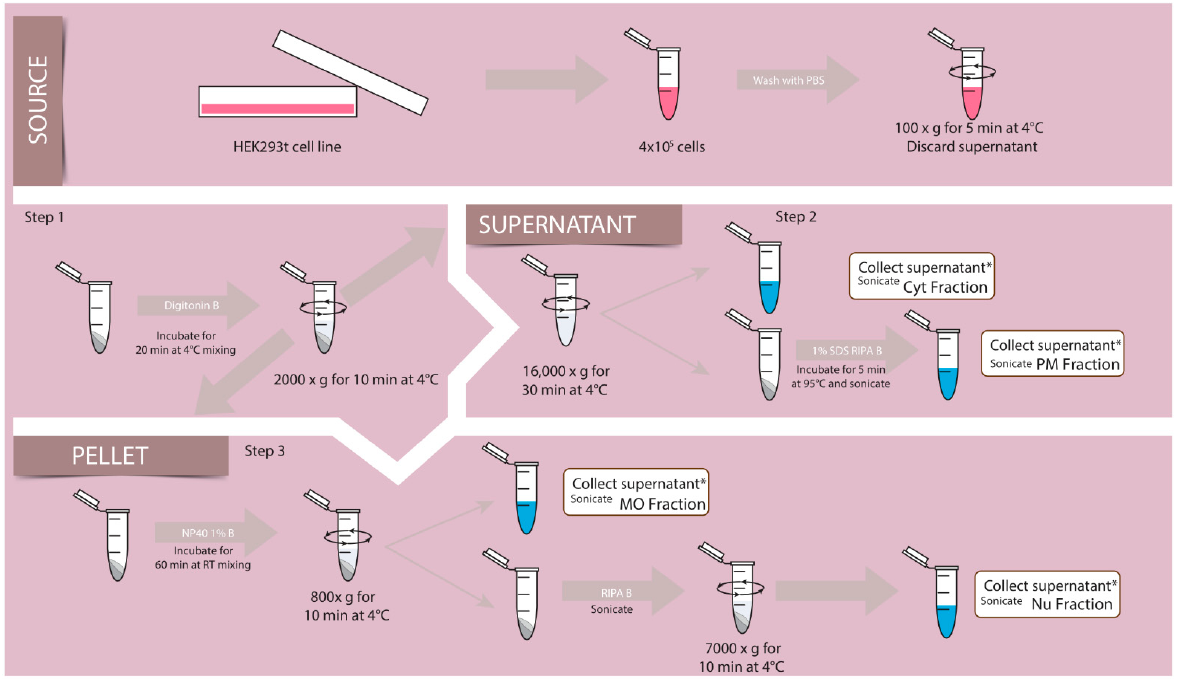
Figure 1. Schematic representation of the fractionation method. HEK293 cells (source) grown on plates were subjected to different steps to obtain the proper cell density to expose them to buffers (B) containing different detergents (arrows) and centrifugation (circle arrow) to obtain different supernatant and pellets enriched in Cyt, PM, MO, Nu fractions. Details in scheme and Material and Methods section. (*) final fractions. Details in scheme and Material and Methods section.